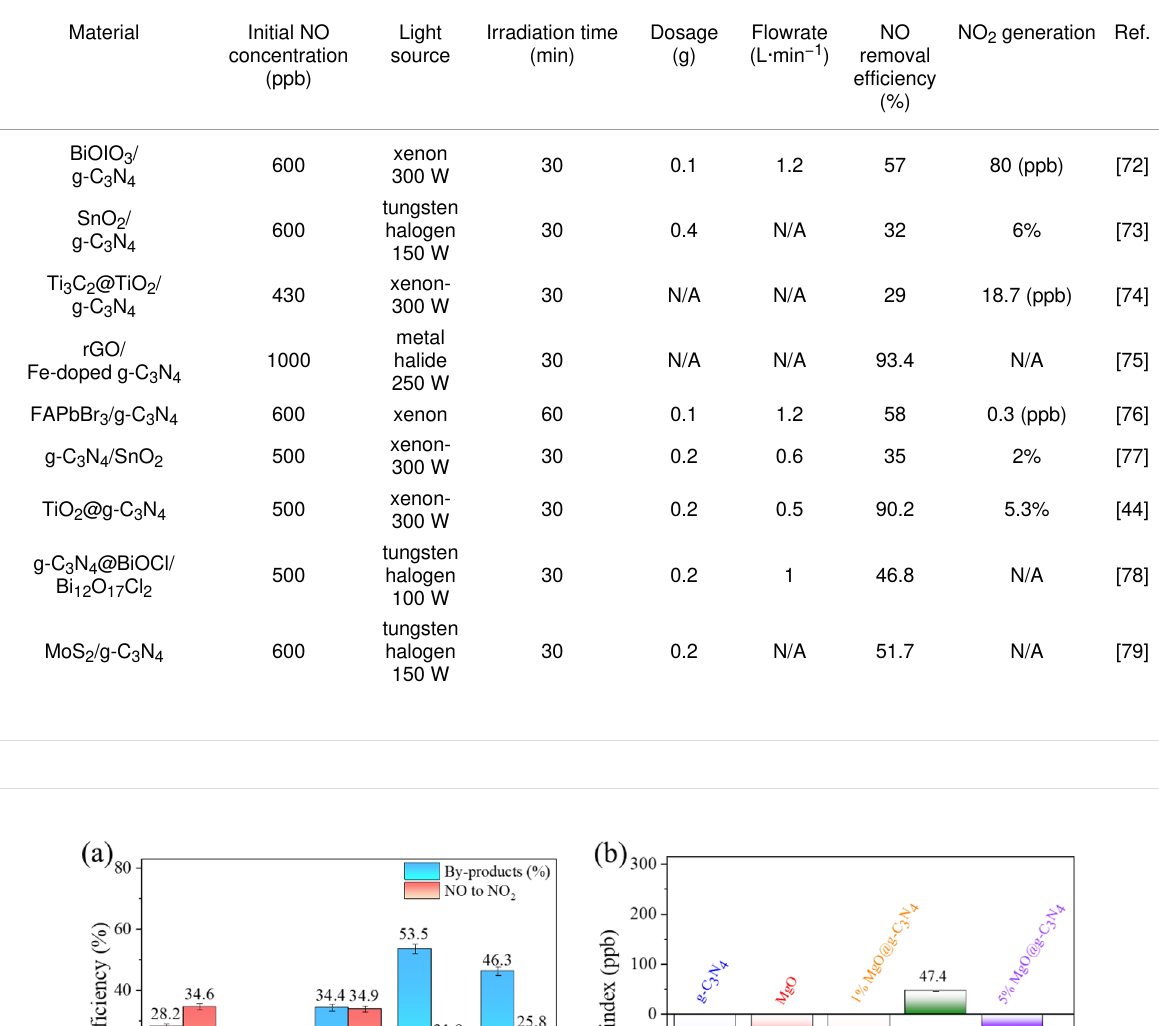
Table 1: Comparison of photocatalytic NO removal of current photocatalyst systems under visible light.